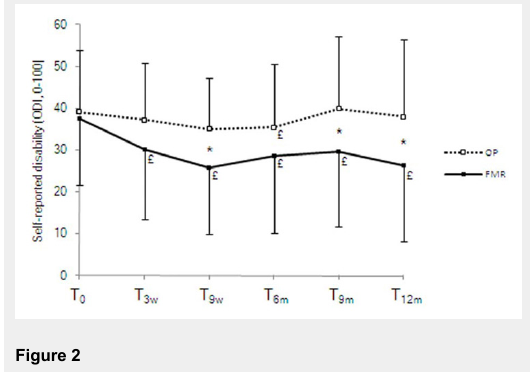
Self-reported disability (Oswestry disability index, ODI) for outpatient physiotherapy (OP) and functional multidisciplinary rehabilitation (FMR) at baseline (T 0 ), 3-week (T 3w ), 9-week (T 9w ), 6-month (T 6m ), 9-month (T 9m ) and 12-month (T 12m ) follow-up. £ indicates a significant within group difference compared to baseline; *, significant between groups difference.